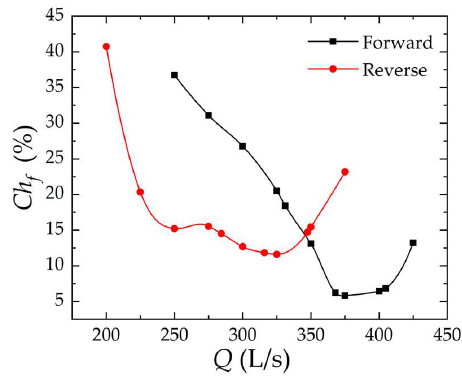
Figure 8. Proportion of hydraulic loss.